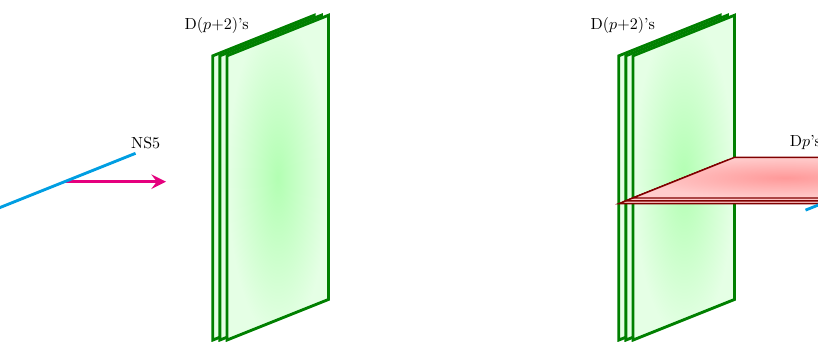
Figure 1 . Hanany-Witten e(cid:11)ect [68]: when an NS5-brane crosses M D( p +2)-branes, M D p -branes will appear stretching between the